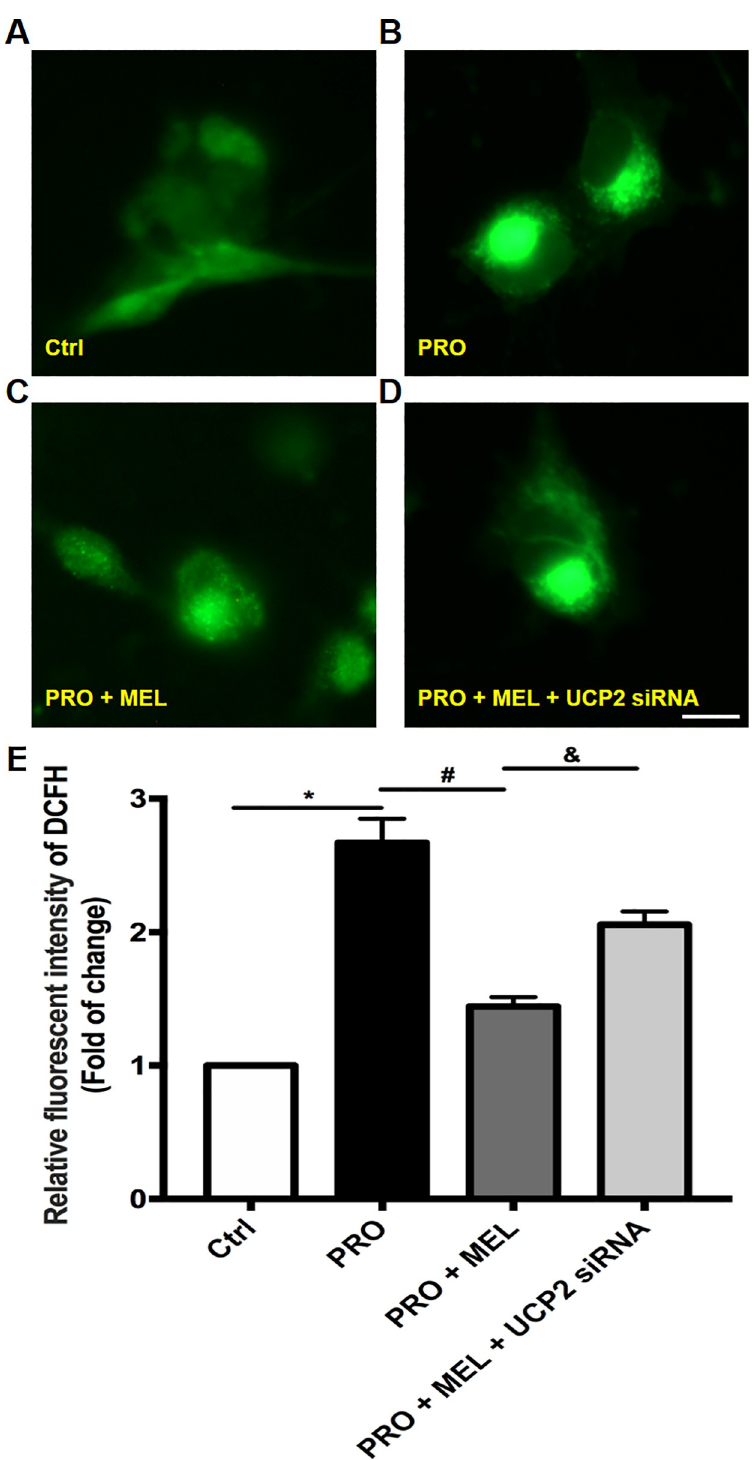
Fig 2. ROS production was evaluated by using DCFH-DA-associated fluorescent microscopic photographs and histogram. ROS production in control, PRO, MEL+PRO with or without UCP2 siRNA-treated in microglia (A–D) and related quantification (E) were shown. The histogram showed melatonin attenuated the ROS levels compared to that of prorenin. While in the presence of UCP2 siRNA, melatonin could not reduce the level of ROS levels. Statistical significance between groups was evaluated by one-factor ANOVA. Data are mean ± SEM. n = 3, � p < 0.05 vs. the control group, # p < 0.05 vs. PRO group, & p < 0.05 vs.100 μ M MEL-treated group. Scale bar: 10 μ m. https://doi.org/10.1371/journal.pone.0212138.g002 PLOS ONE | https://doi.org/10.1371/journal.pone.0212138 February 11,